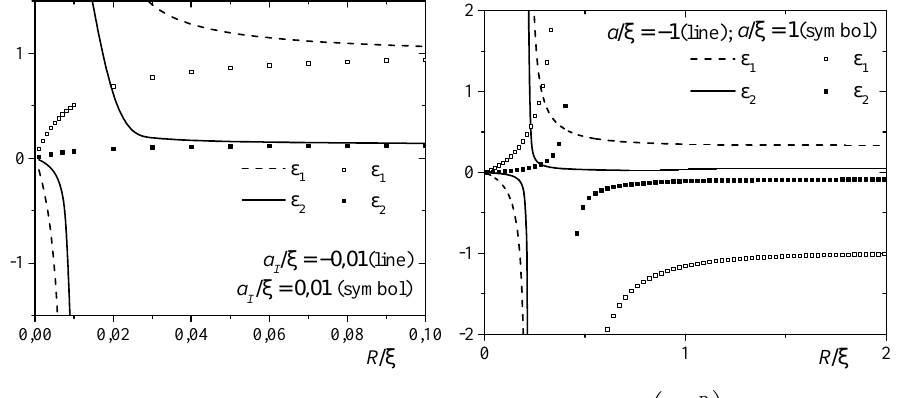
Figure 2. Mean-field and the first-order quantum corrections ε 1,2 Bose gas generated by two impurities for a I